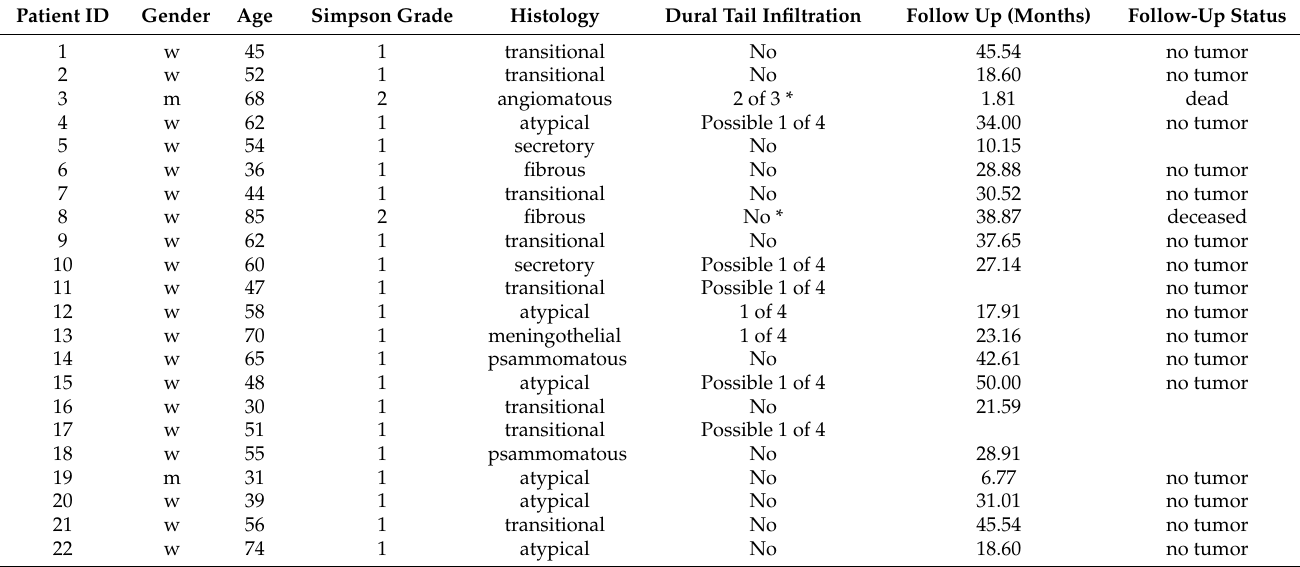
Table 1. Patient and tumor characteristics of the study